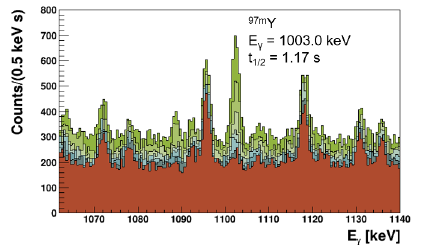
Figure 5. A measured γ -ray spectra taken using cyclic activation of 238 U( n , f ) at E n = 2 . 0 MeV, with 4 s irradiation, 1.1 s transit, and 8 s counting time. Each histogram represents a 1 s counting interval. The strong 1003.0 keV line results from the decay of 97 m Y + 97 Y, with half-lives of 1.17 and 3.75 s,